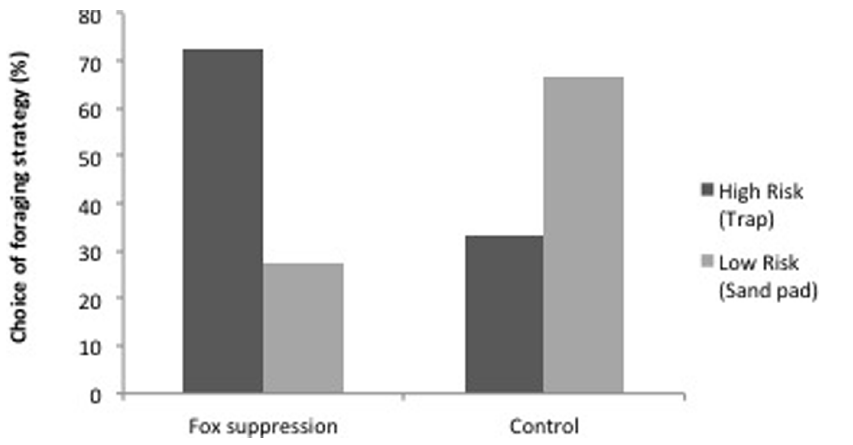
Figure 4. Foraging choice (%) of lace monitors ( Varanusvarius ) in areas of fox suppression (with low densities of foxes) and control (high densities of foxes). Choice of foraging behaviour was between high risk-high reward sites (represented by traps) vs. low risk-low reward sites (represented by sand pads).